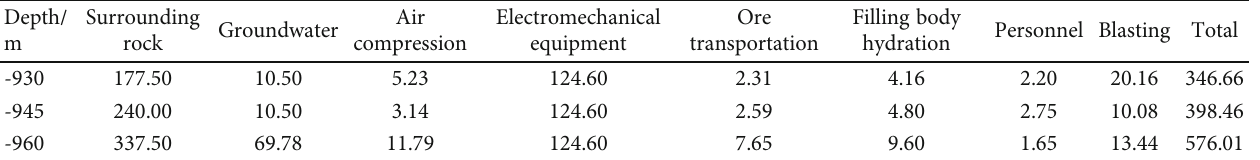
Table 6: Summary of heat release (kW).